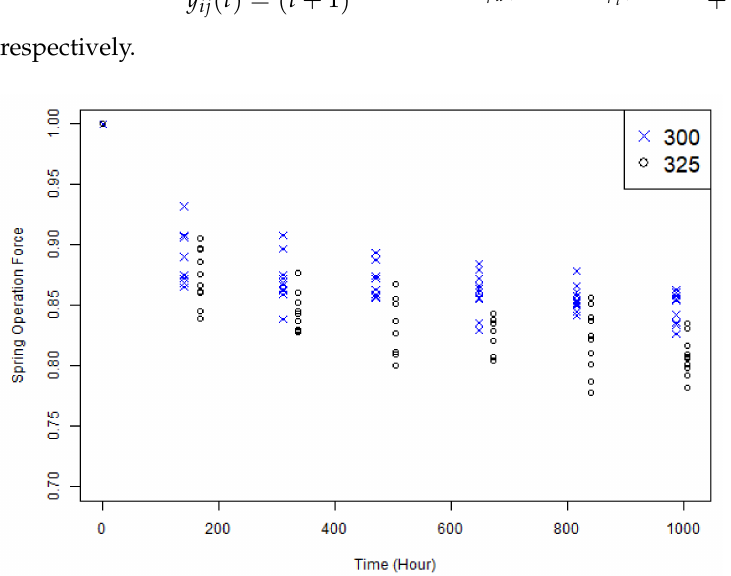
Figure 9. Degradation paths of actuating forces for return-springs at 300 ◦ C and 325 ◦